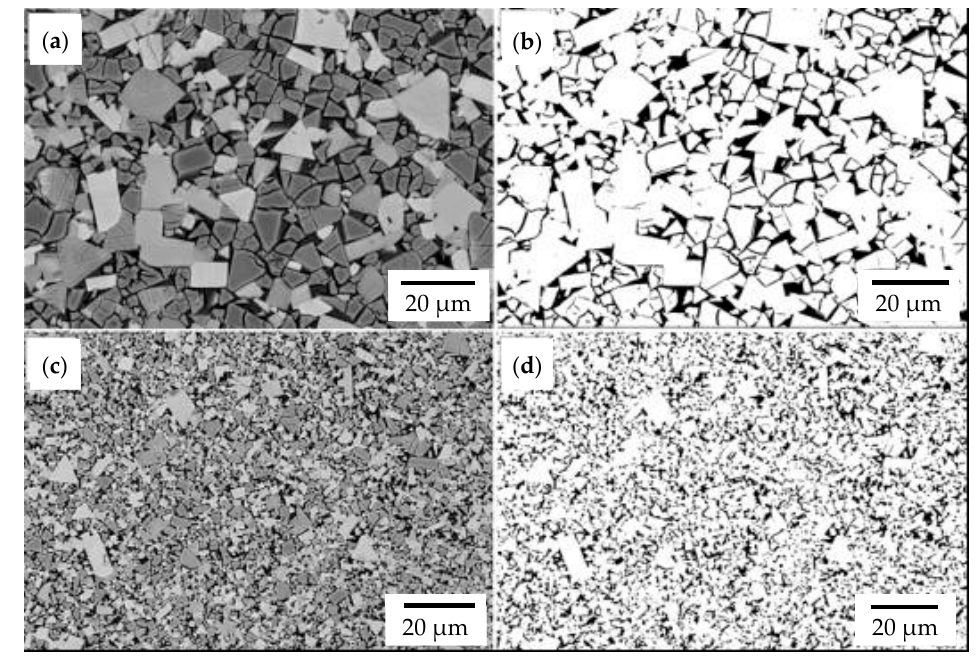
Figure 8. An example of the areas used for quantitative graphical image analysis. Reference images of chisels A ( a ) and chisels B ( c ). Images after threshold intended for calculation of carbide and matrix share of chisels A ( b ) and chisels B ( d ). SEM, BSE detector.